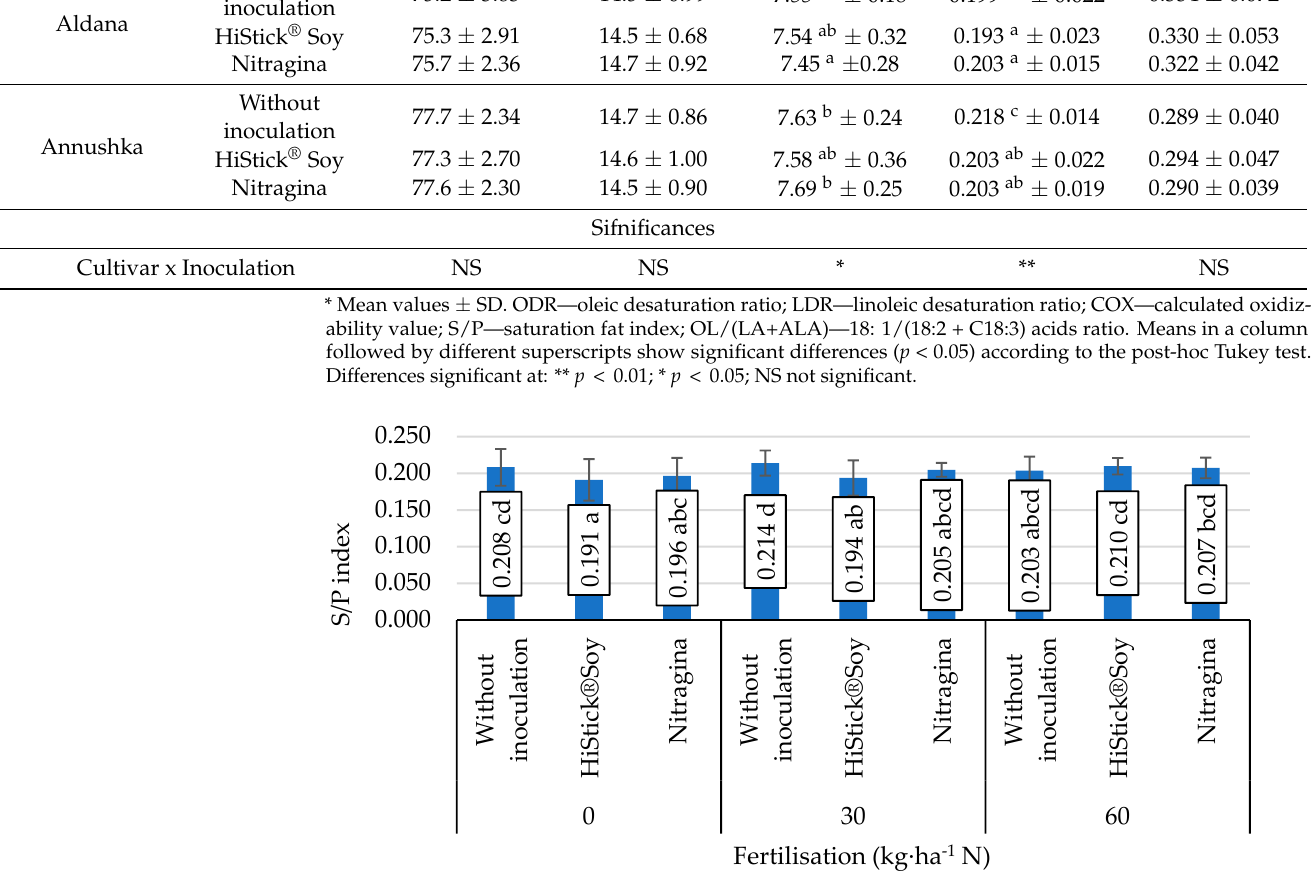
14 of 22 Figure 1. Value of the saturation fat index (S/P), mean values for interaction nitrogen fertiliser ap- plication × years. Mean values ± SD. Means followed by different superscripts show significant dif-